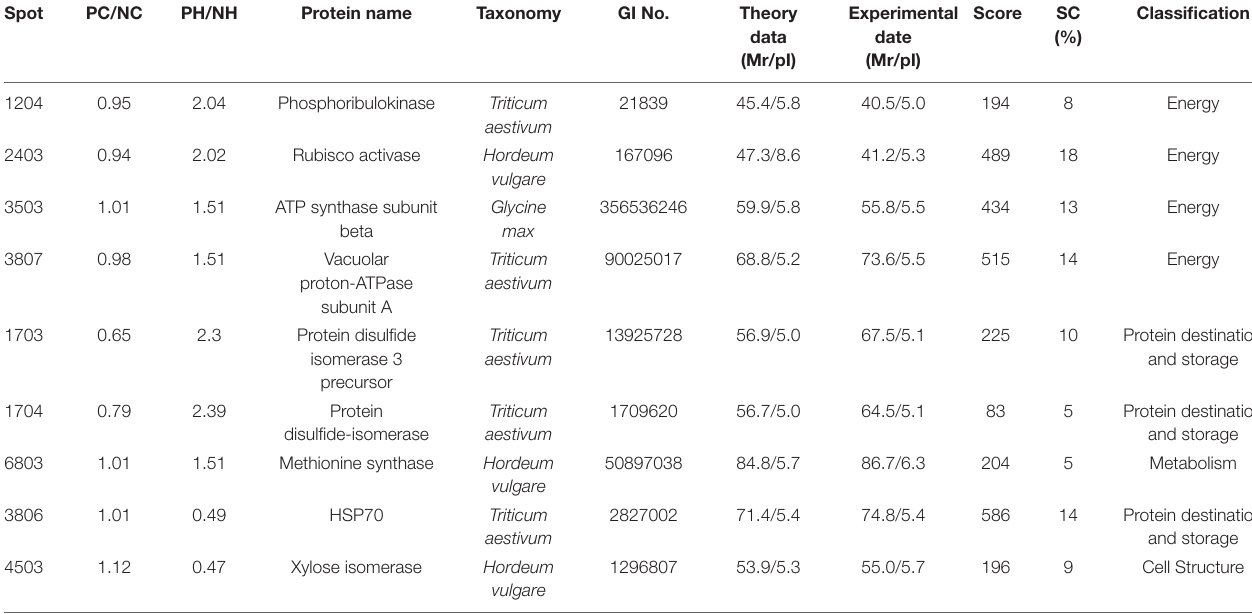
TABLE 2 | Differentially expressed proteins between progenies of primed and non-primed plants under high-temperature stress during grain filling. Spot PC/NC PH/NH Protein name Taxonomy GI